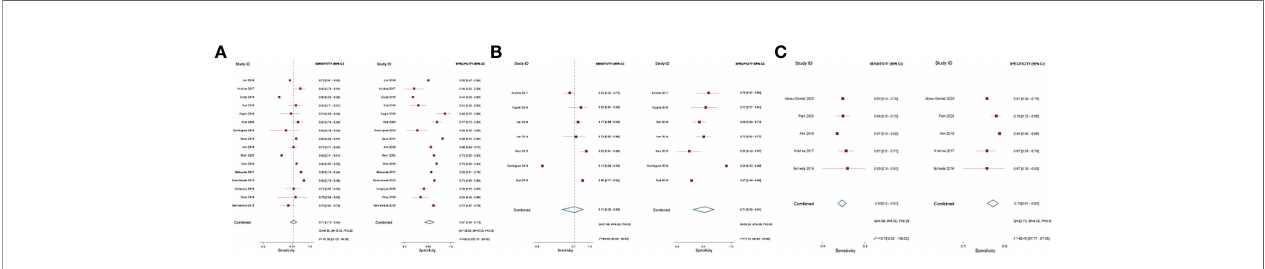
FIGURE 3 | Coupled forest plot of pooled sensitivity and speci fi city. Numbers are pooled estimates with 95% CI in parentheses. Corresponding heterogeneity statistics are provided at bottom right corners. Horizontal lines indicate 95% con fi dence intervals. (A) Length of capsular contact; (B) apparent diffusion coef fi cient; (C) tumor size.